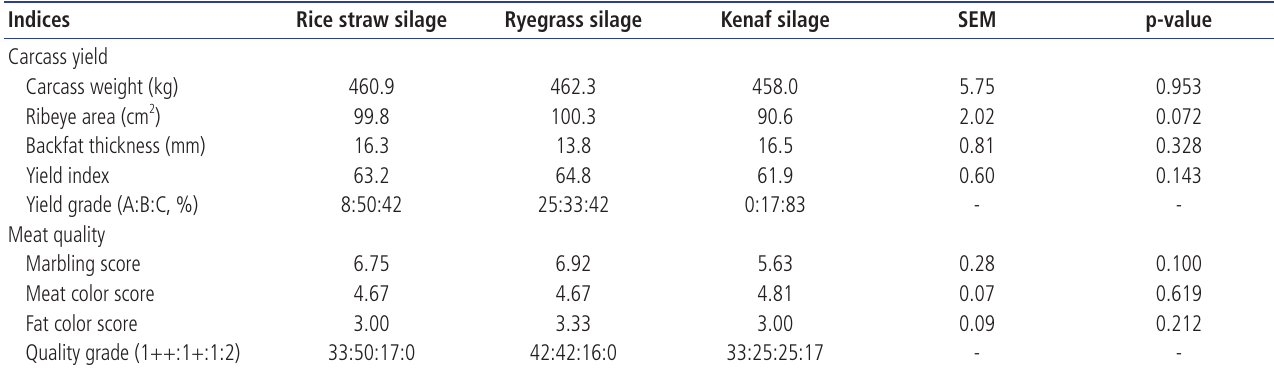
Table 4. Effect of kenaf silage feeding to Hanwoo steers on carcass yield and meat quality 1)